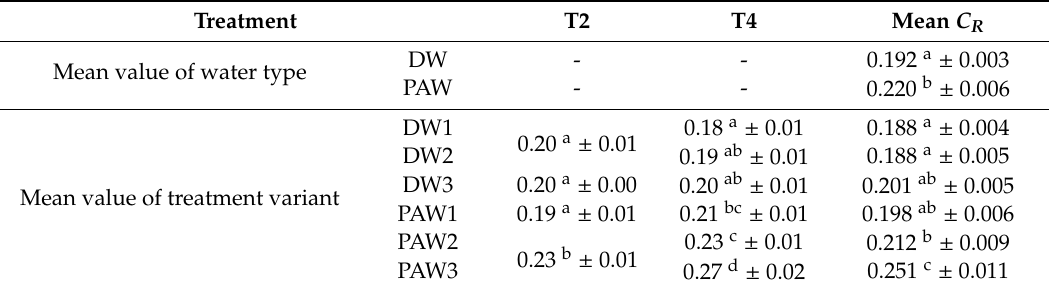
Table 5. Influence of PAW application on root electrical capacitance ( C R ) in nano-farads (nF).